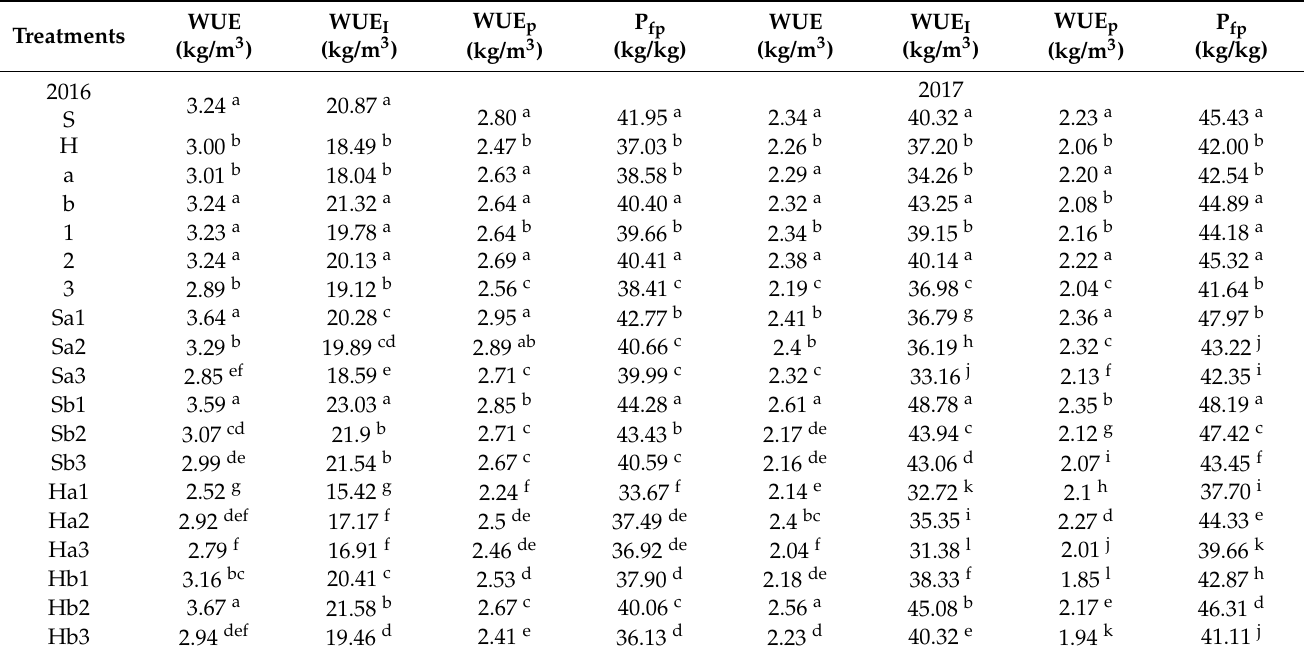
Table 5. WUE, WUE I , WUE p , and P fp